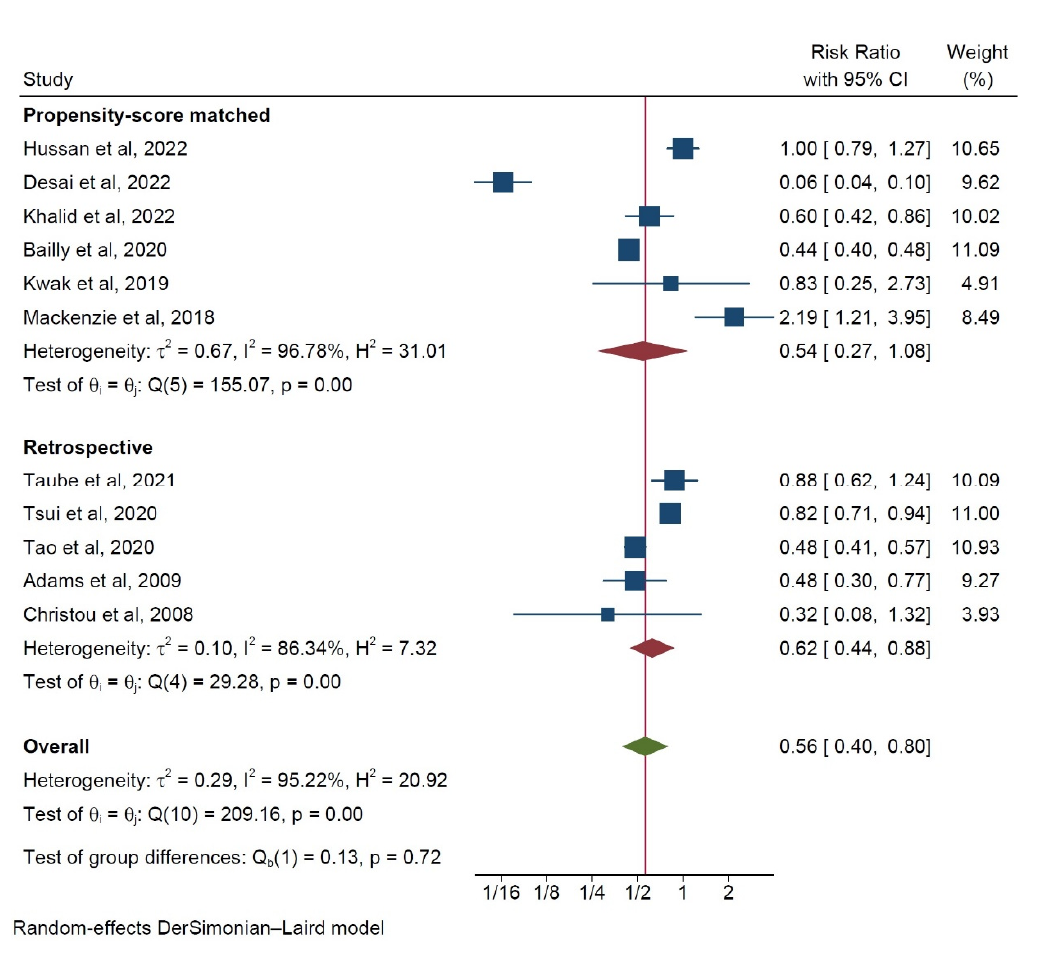
Figure 7. Subgroup analysis of incidence rates of colorectal cancer depending on study type